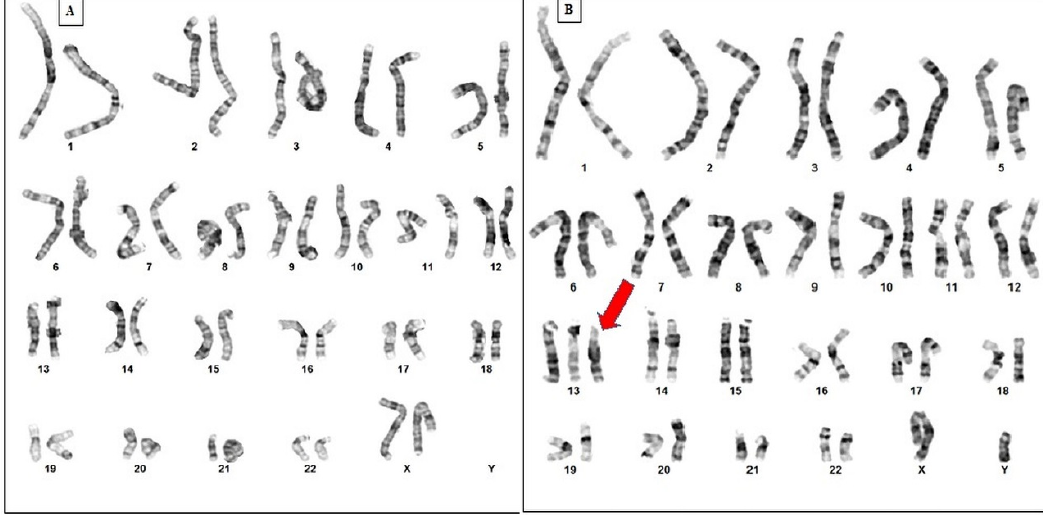
Table 1. Important pathogenic genes located on chromosome 13.